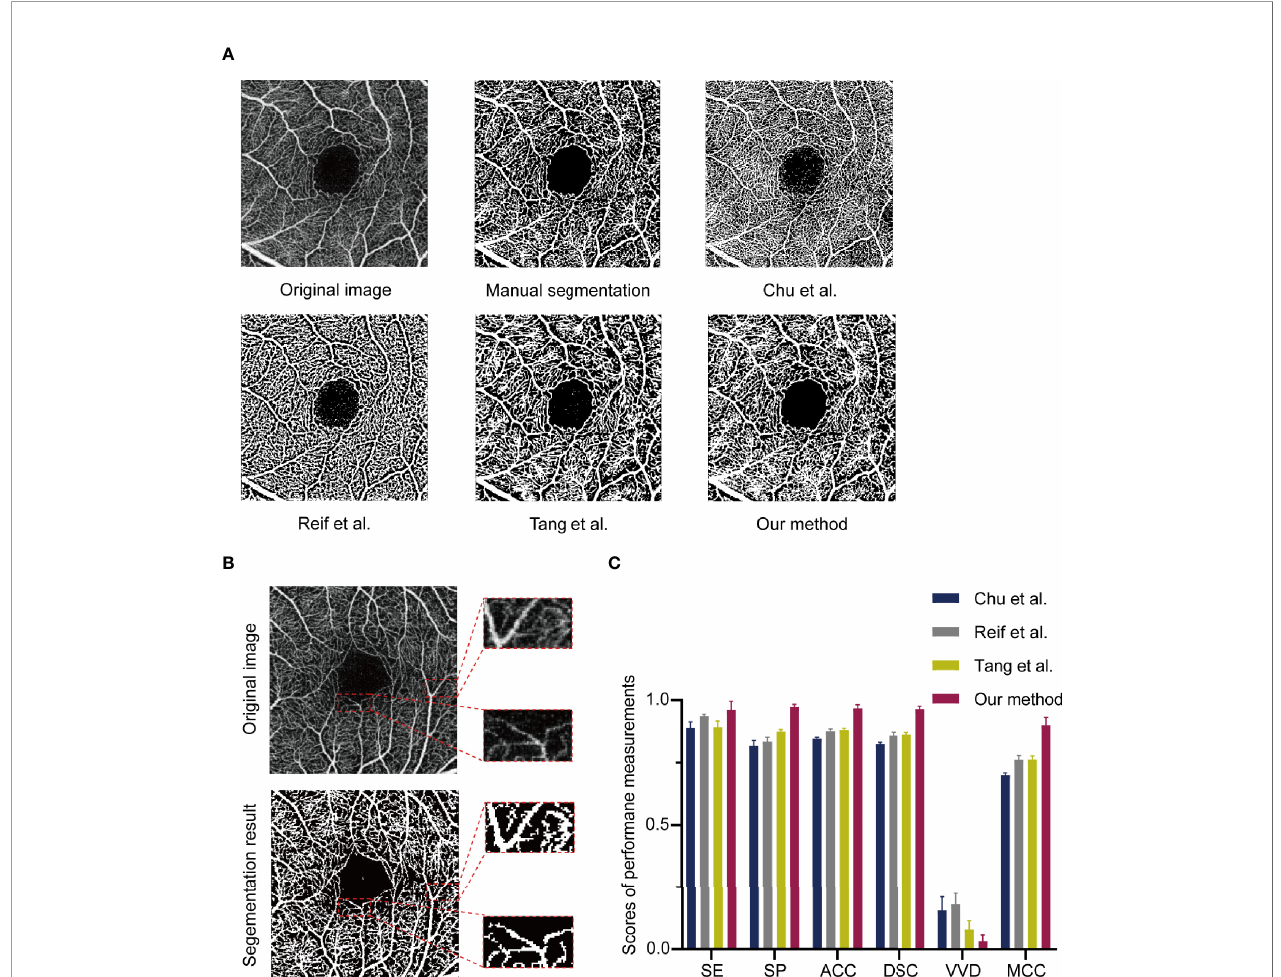
FIGURE 2 | The assessment of the multi-branch retinal vessel segmentation method (MRVSM). (A) Comparison of results of segmentation methods. (B) Segmentation results of MRVSM in the low contrast region. (C) The scores of sensitivity (SE), speci fi city (SP), accuracy (ACC), absolute vessel volume difference (VVD), dice similarity coef fi cient (DSC), and Matthews correlation coef fi cient (MCC) of the segmentation methods. Data were presented as the mean ±